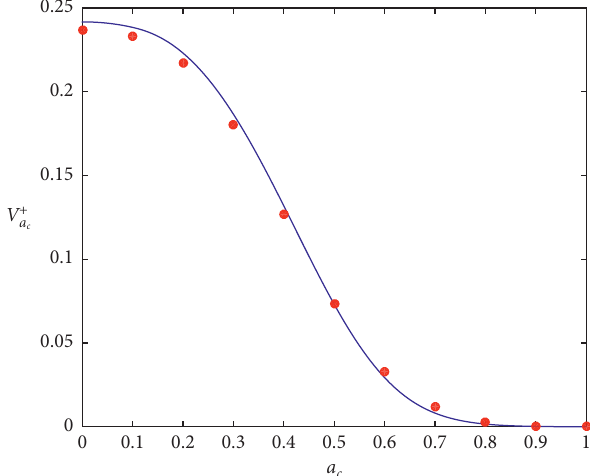
Figure 9: The mean up-crossing rate υ + results.